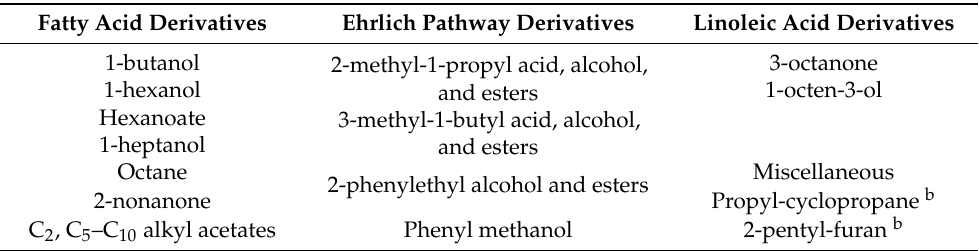
Table 1. Commonly reported functionalized hydrocarbons from A. sarcoides NRRL 50072 a organized by hypothesized production pathway.